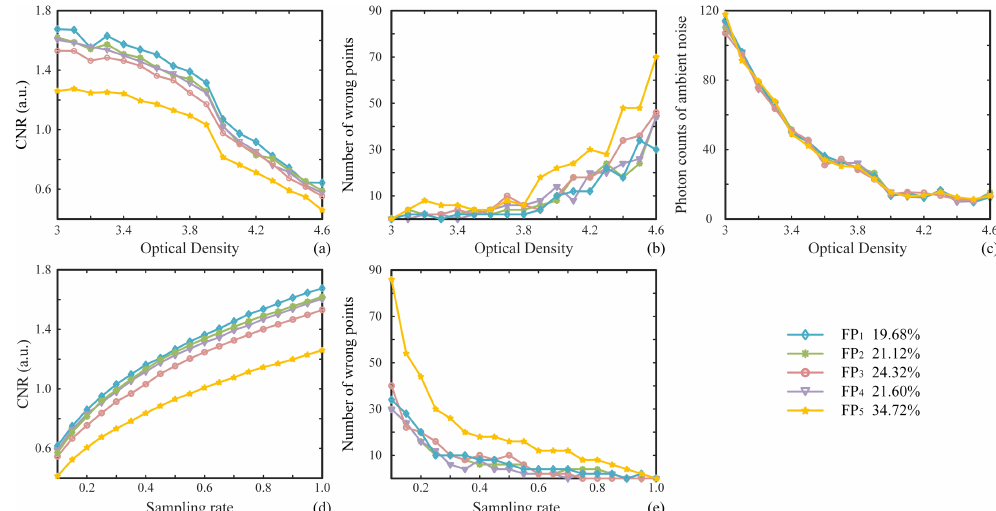
Figure 5. Correctness analysis of the binarized FPs. ( a , b ) The variation trends of contrast-to-noise ratios (CNRs) and the number of wrong points with the increase in the attenuation coefficient optical density (OD), corresponding to the five recovered results, respectively. ( c ) The photon counts of background noise as a function of the OD value. ( d , e ) The trends of CNRs and the number of wrong points with the increase in the sampling rate. The corresponding ratios of the numbers of ones in five original FPs to the total 25 × 25 pixel-units are listed in the